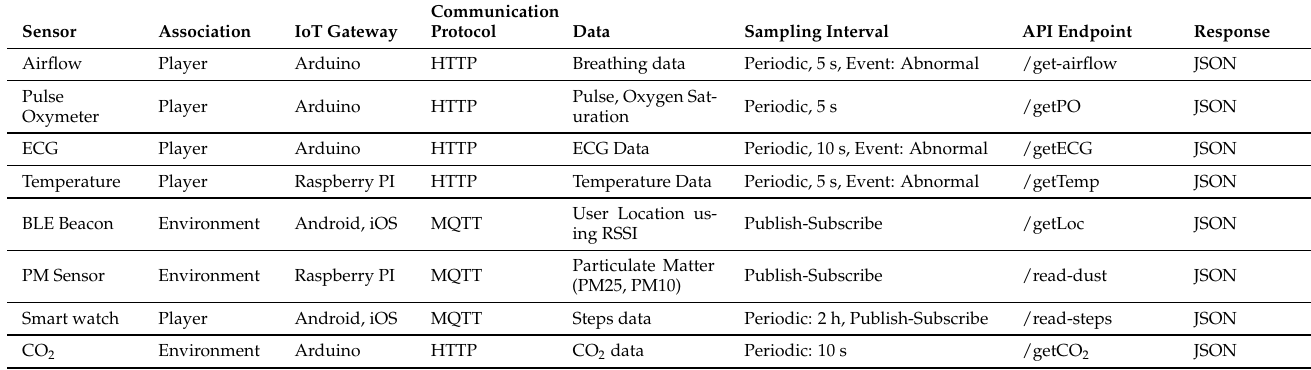
Table 5. Overview of data access points from different devices connected to IoT